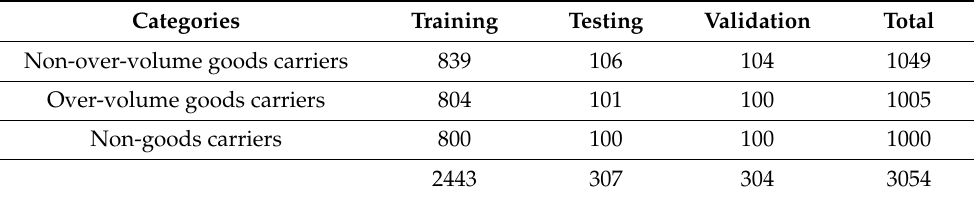
Table 2. Detailed description of the dataset consisting of three different classes.